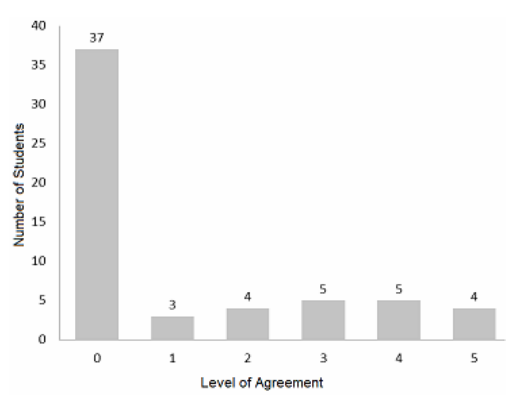
Figure 4. "Tutors were effectively used in the course"